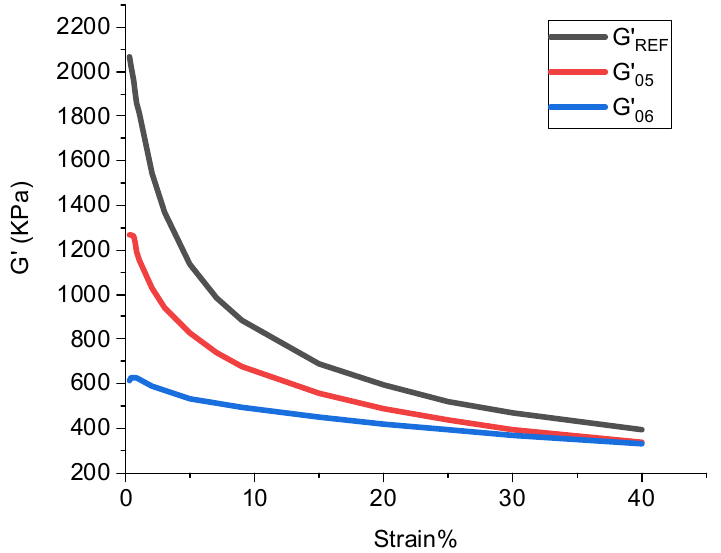
Figure 1. Distribution of silanization reaction degree.